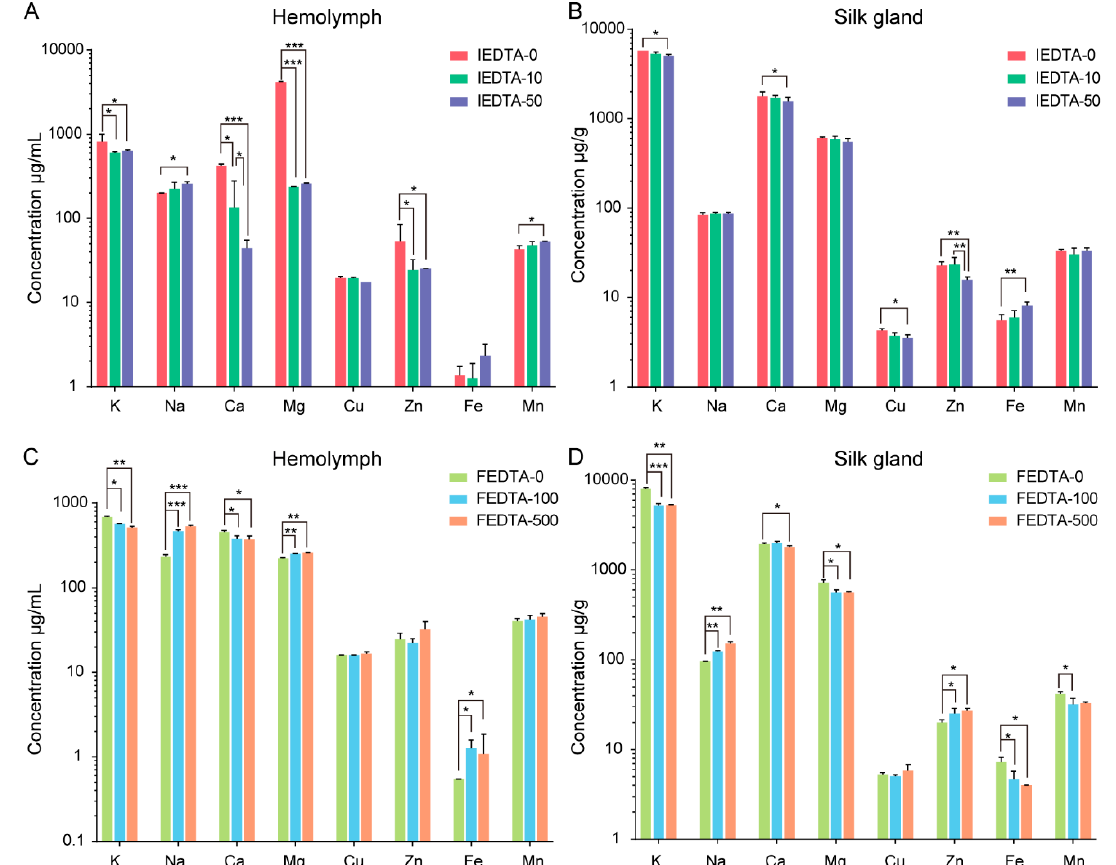
Figure 2. The contents of metal elements in the hemolymph and the silk gland after treatment with EDTA. ( A ) Hemolymph after being injected with EDTA. ( B ) Silk gland after being injected with EDTA. ( C ) Hemolymph after being fed with EDTA. ( D ) Silk gland after being fed with EDTA. Error bars, SD; * p < 0.05, ** p < 0.01, *** p < 0.001 (One-way ANOVA). y -Axis data was processed by log 10.